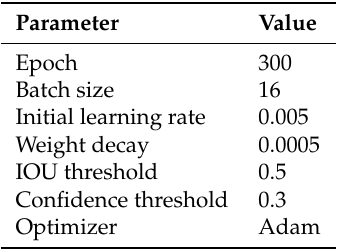
Table 2. Training parameter